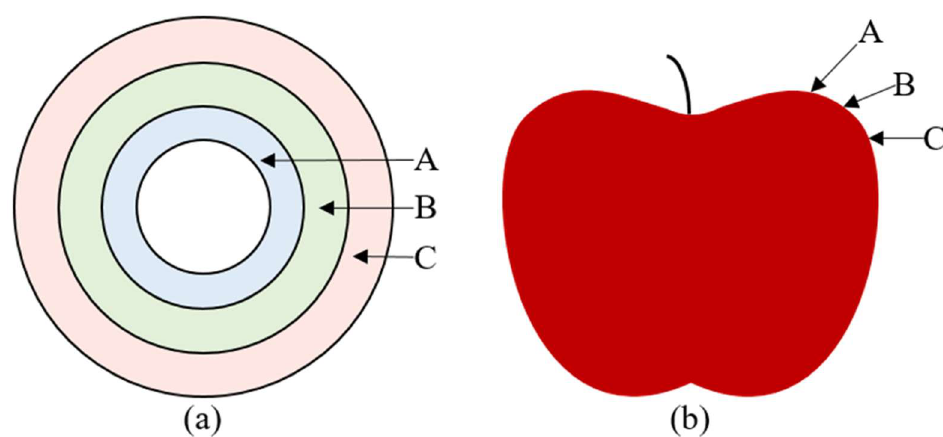
Figure 5. The apple models with labels.